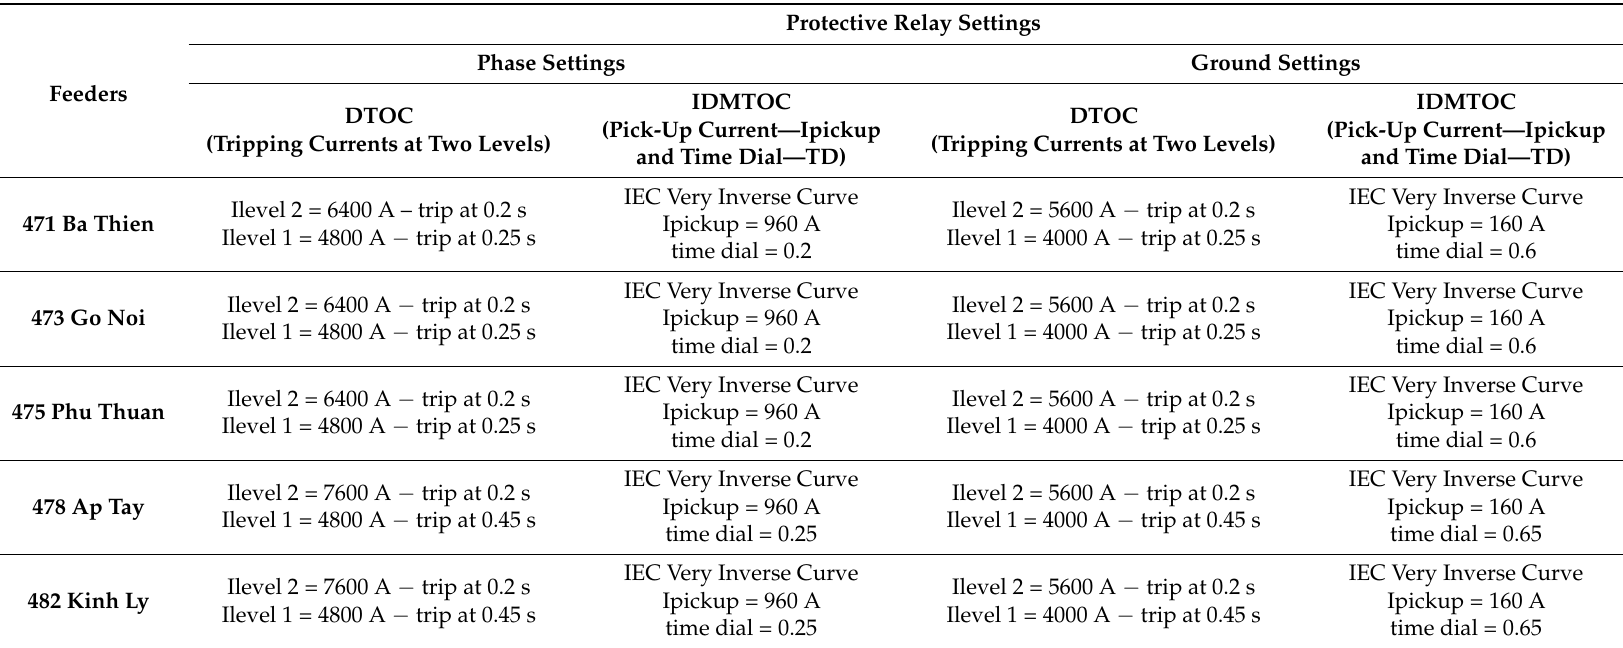
Table 8. Setting of overcurrent relays in the BAU DUNG power substation (a ratio of current transformer (CT) is 800/1 and a ratio of voltage transformer (VT) is 22 kV/110